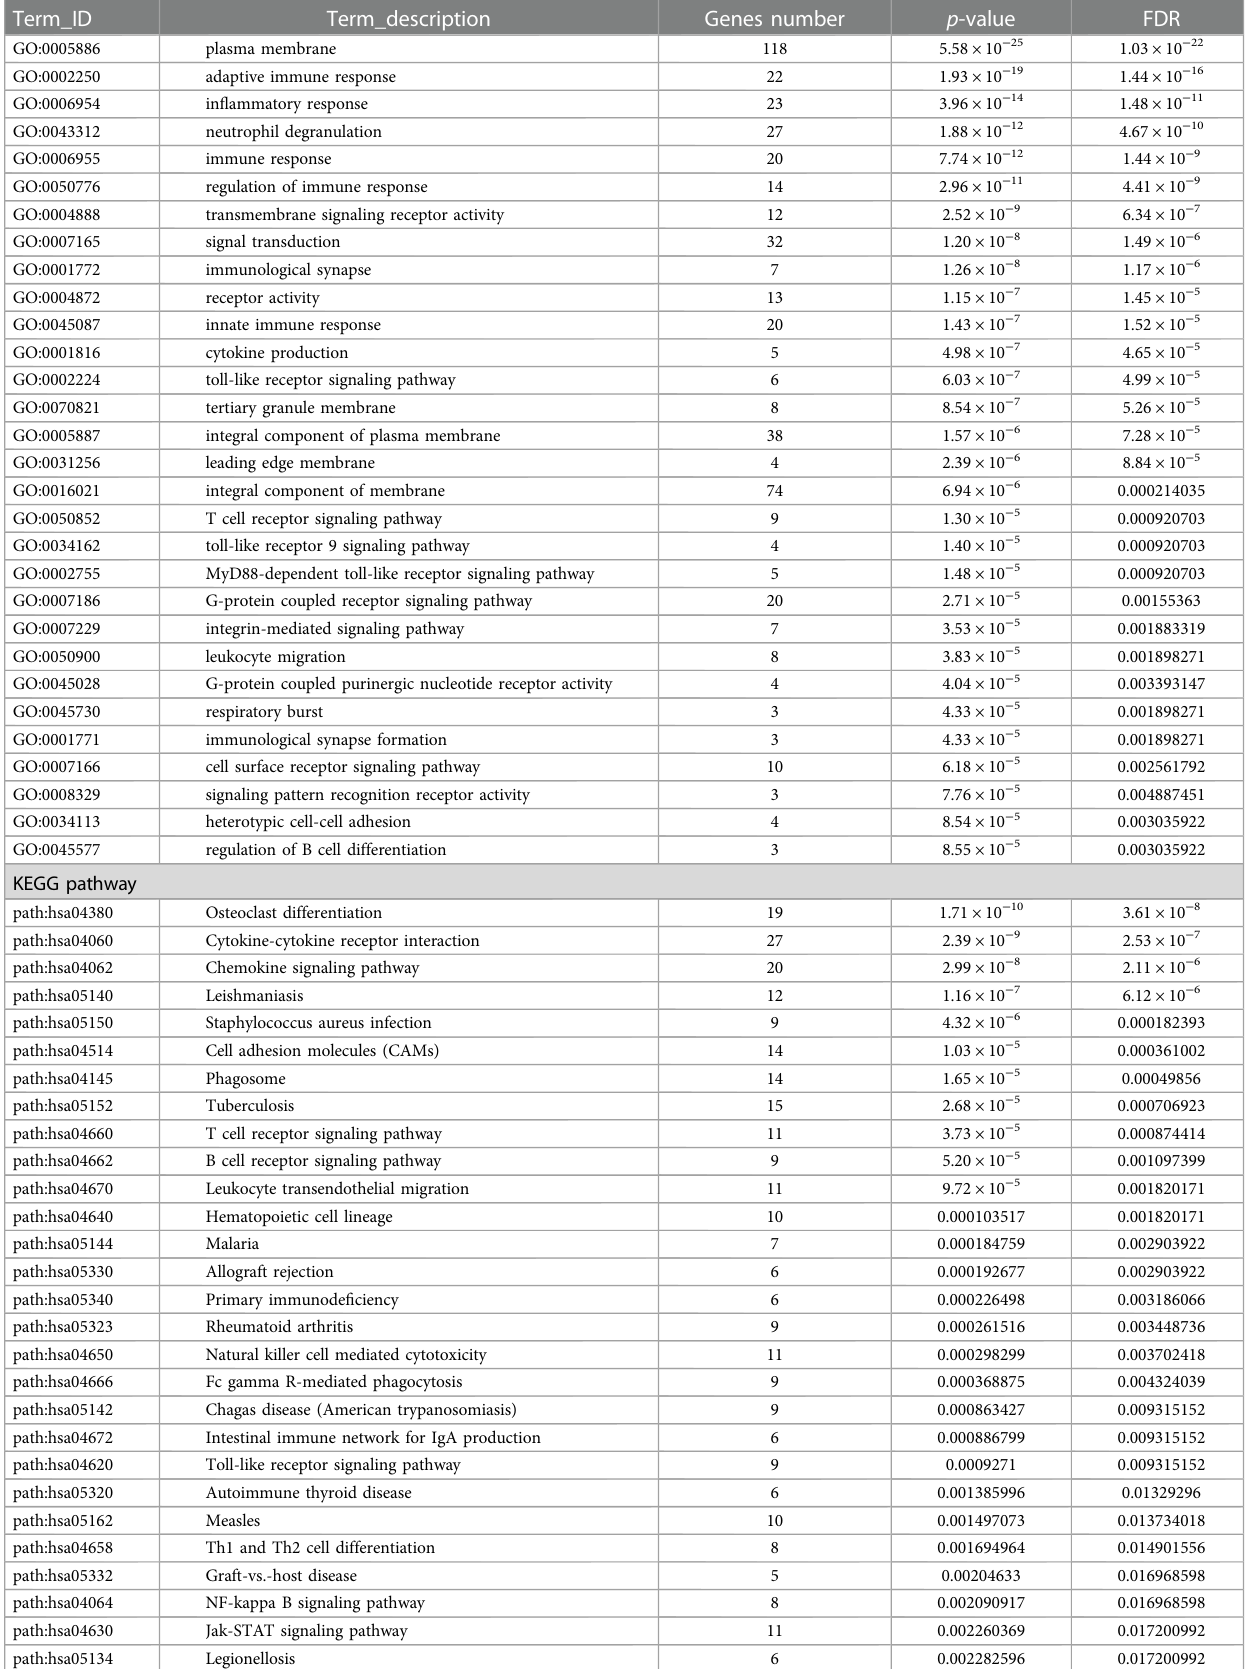
TABLE 3 Top 30 enriched GO terms and KEGG pathways of DEGs in the